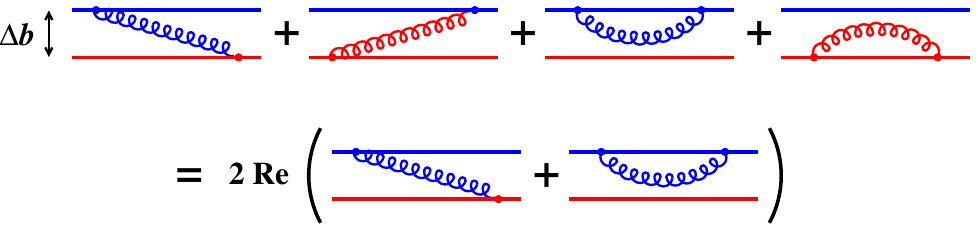
Figure 7 . The diagrams underlying the LMW calculation. The Wilson lines and the radiated soft gluon line are all implicitly interacting with the